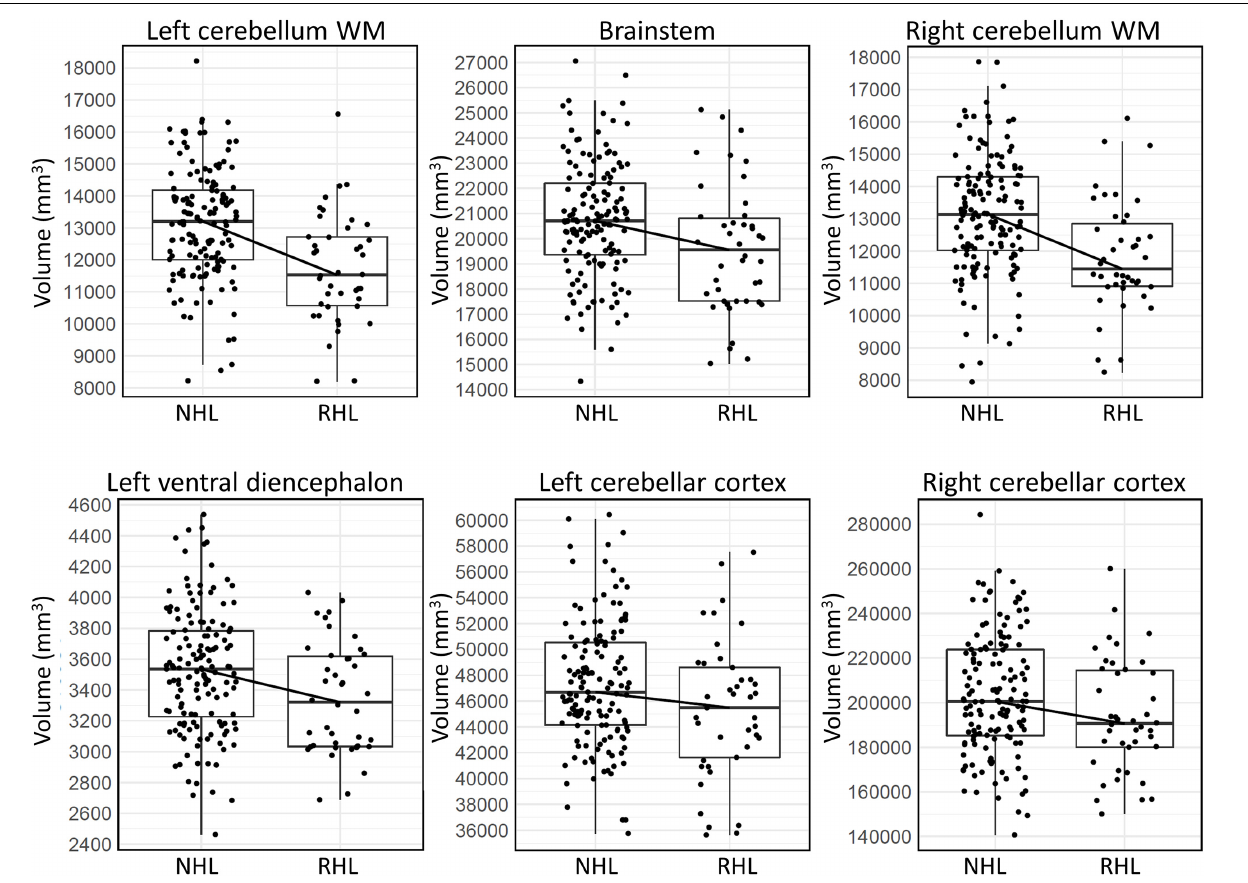
FIGURE 2 | Box plots showing the median, first and third quartiles of the distributions, demonstrating differences in volumes of the six brain regions in AD subjects that significantly differentiated RHL from NHL subjects. WM, white matter. TABLE 5 | Slopes of decline of composite volume score in NHL vs. RHL subjects, starting at cognitively normal, MCI or AD state. Composite of six significant regional features between RHL and NHL in AD subjects at baseline Cognitively